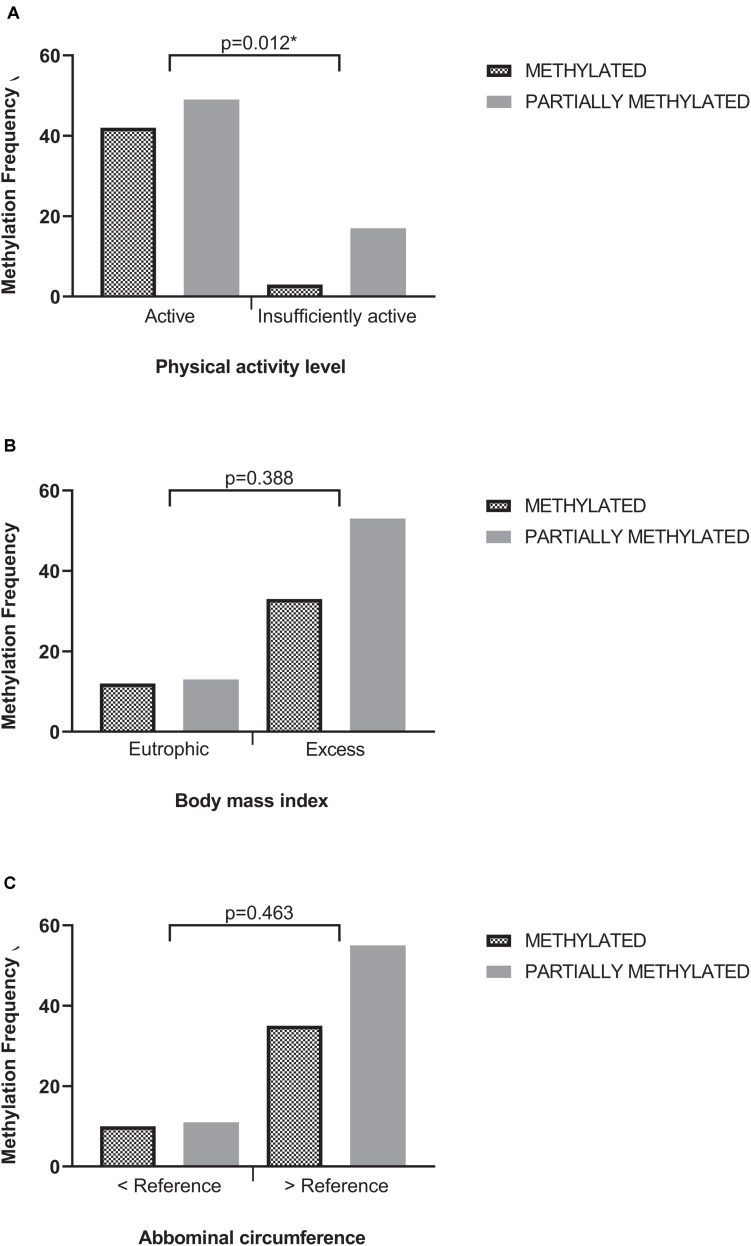
Methylation profile according to physical activity level (A), body mass index (B), and abdominal circumference (C). Chi-square test; p = value of significance. AC, Abdominal circumference.